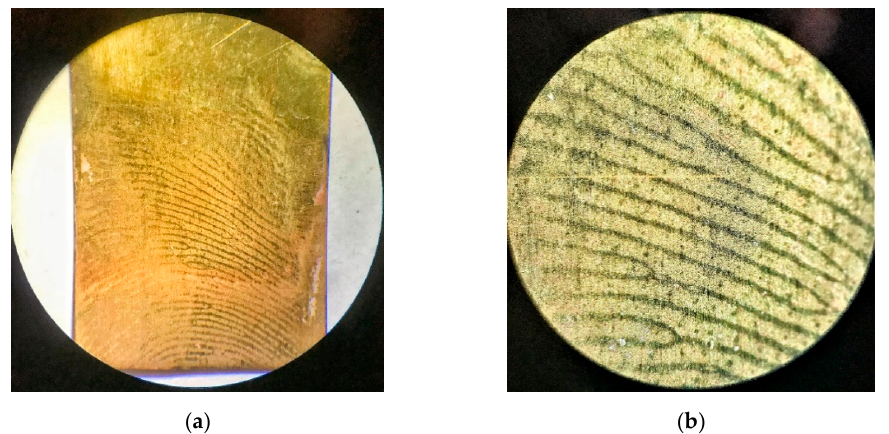
Figure 4. Visualized fingerprint on brass plates. Images were taken with a binocular magnifier: ( a ) 10× magnification and ( b ) 30× magnification.